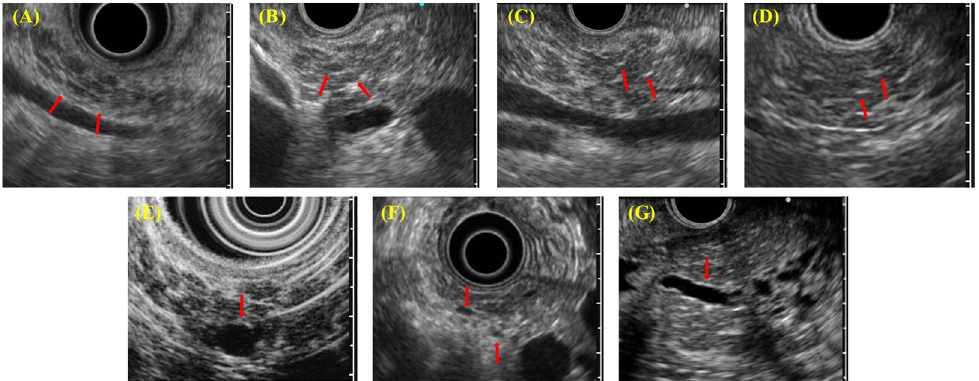
Figure 2. Each endoscopic ultrasound (EUS) finding in diagnostic criteria for early chronic pancreatitis 2009 (DCECP2009). ( A ) Lobularity with honeycombing; ( B ) lobularity without honeycombing; ( C ) hyperechoic foci without shadowing; ( D ) stranding; ( E ) cysts; ( F ) dilated side branches; ( G ) hyperechoic main pancreatic duct (MPD) margins.